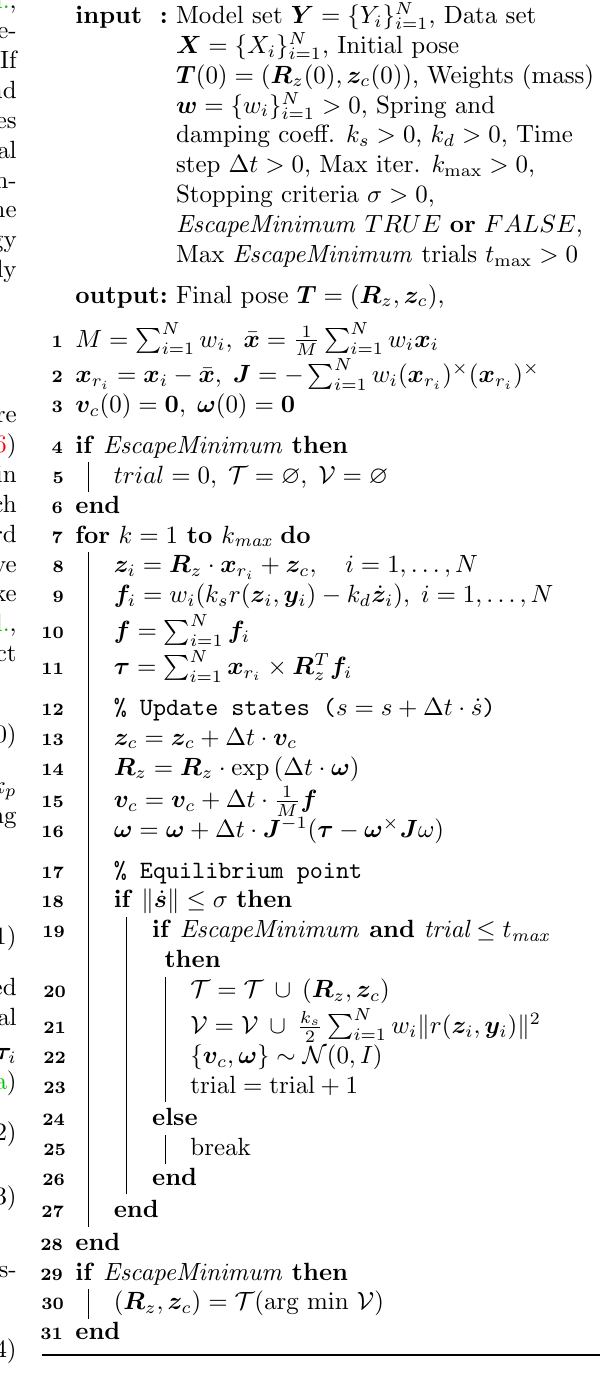
Algorithm 2: DAMP for